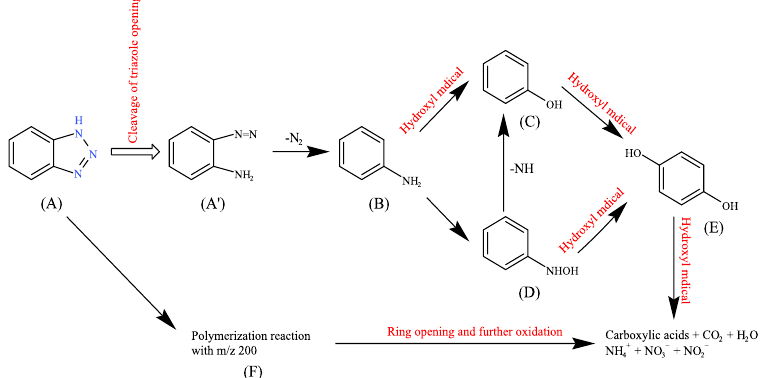
Figure 2. Degradation mechanism of BTA (O 3 = 6.8 mg·L − 1 , pH = 7.0, PMS = 1.71 g/L, US power = 200 W and 60 min).